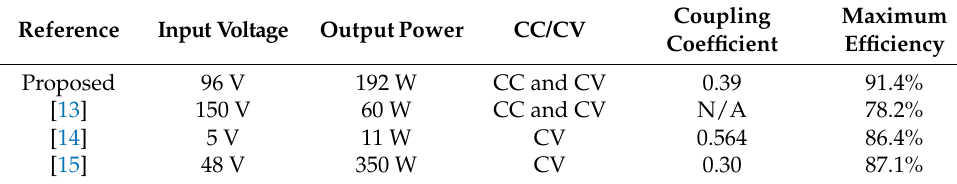
Figure 23. Diagram of efficiency versus the load. Table 3. Performance comparison of single-switch.